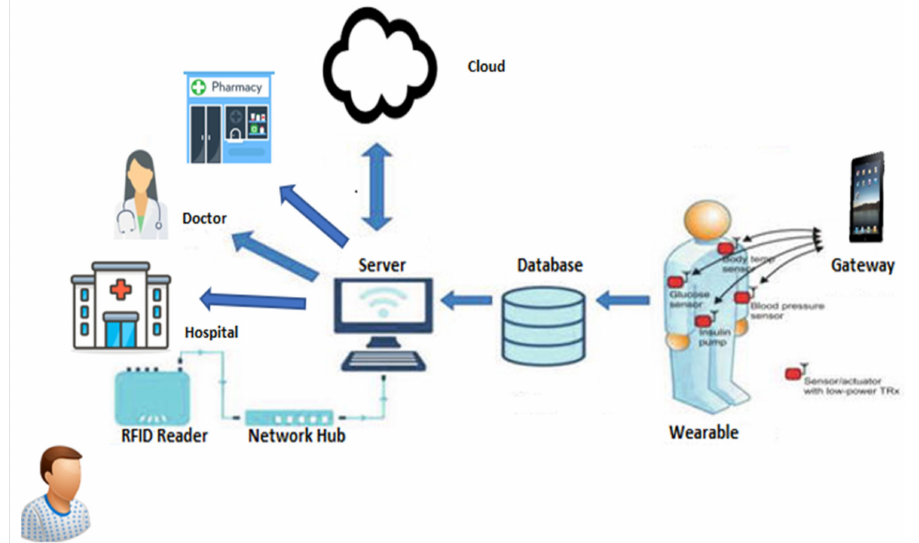
Figure 1. The IoT